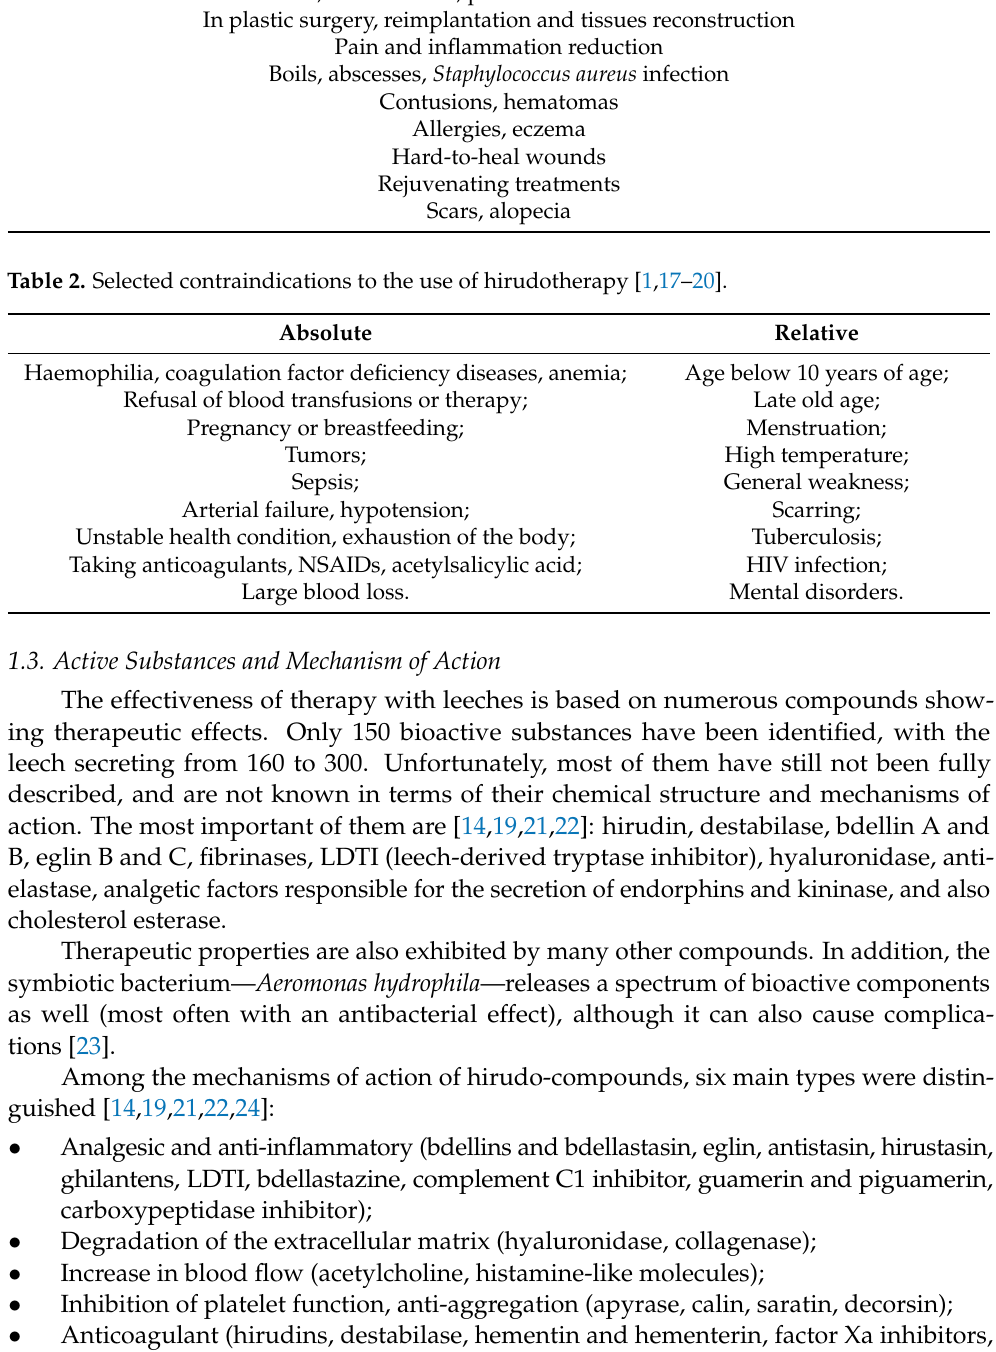
Table 1. Selected indications for the use of hirudotherapy [1,18–20].